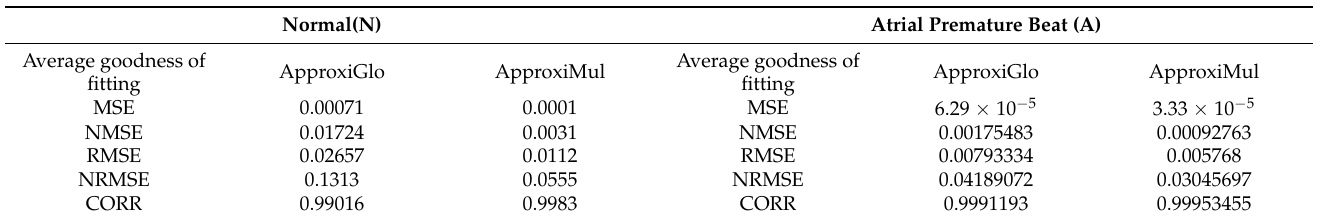
Table 2. Comparison between ApproxiGlo and ApproxiMul for normal and atrial premature beat.